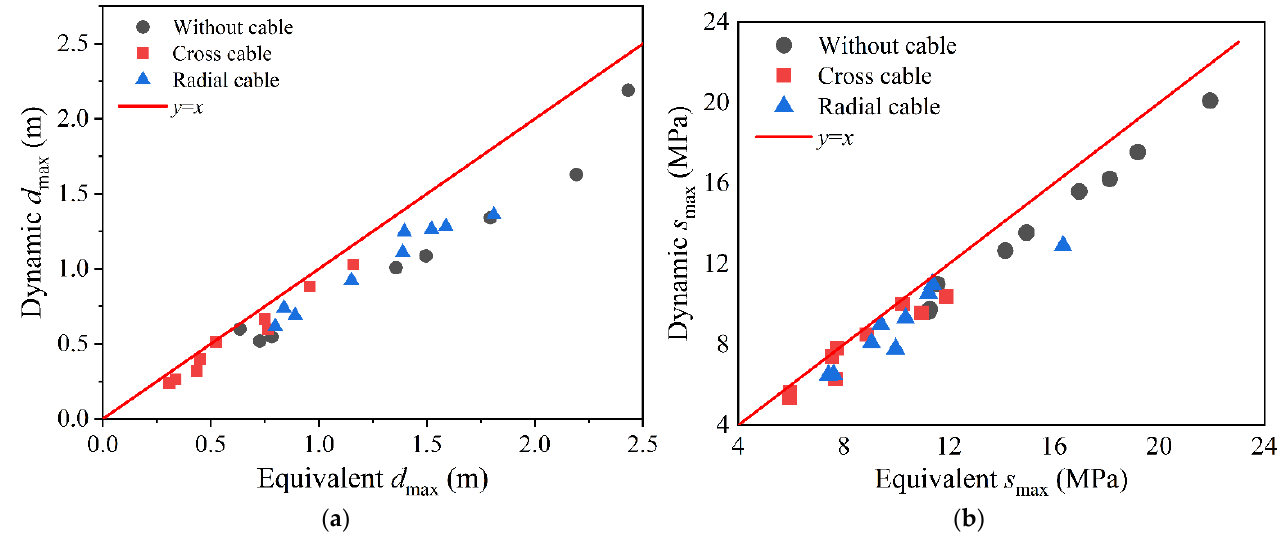
Figure 24. Comparisons between the equivalent response results and nonlinear dynamic analysis results under different cable configurations: ( a ) Displacement; ( b ) Stress.